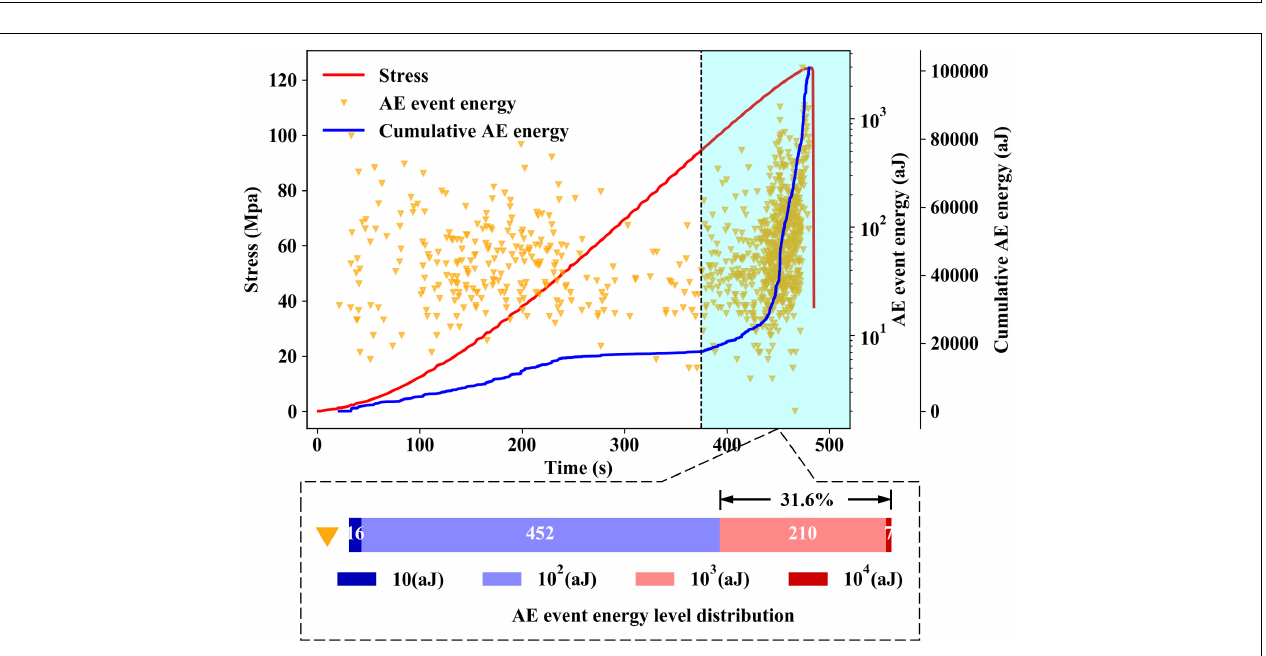
( Figure 5 ). Saturated water granite produce more AE events before failure, but the energy level of AE events are distributed at lower levels, and AE events with energy levels above 10 3 accounts for 31.6% ( Figure 6 ).